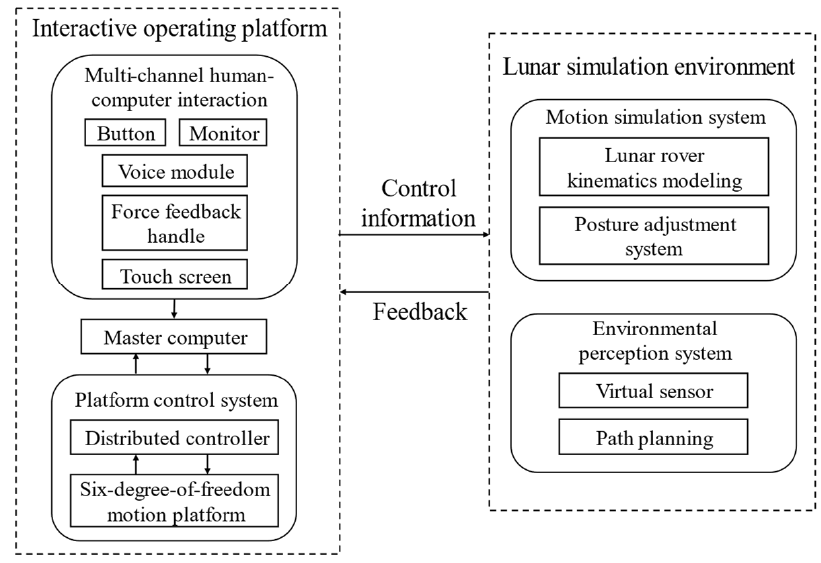
Figure 1. Schematic diagram of the system.